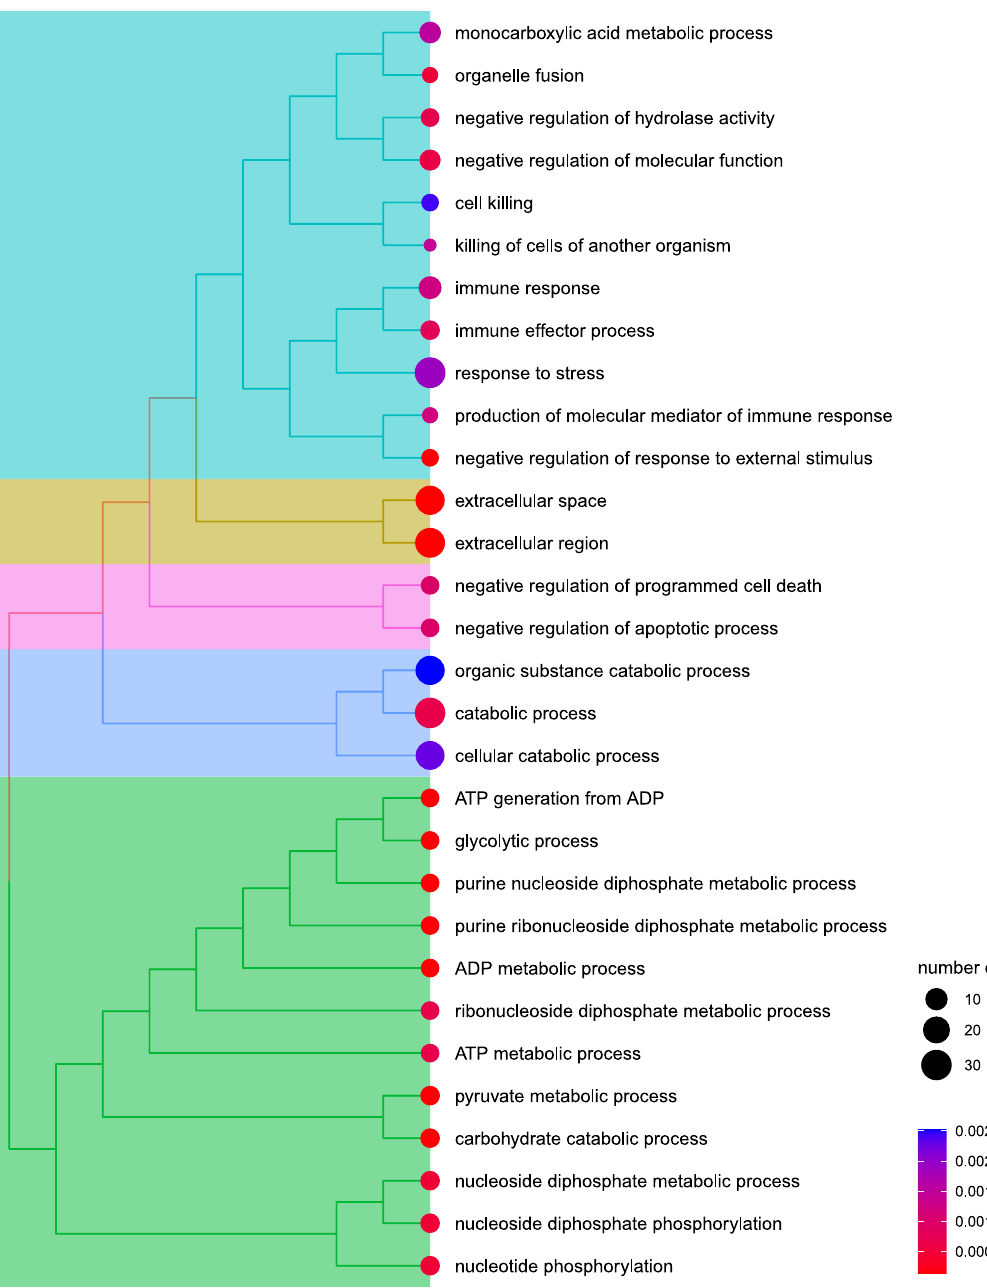
Figure 4. Gene ontology (GO) enrichment analysis of the common nightingale female reproductive tract fluid proteomes. Gene ontology searches revealed that highly expressed proteins are extracellular soluble proteins mostly involved in the maintenance of tissue homeostasis, antimicrobial defence and ATP metabolism. Numbers of enriched genes are reflected by the circle size while Benjamini–Hochberg corrected p-values are scaled from red to blue. Hierarchical clustering of enriched terms relies on the pairwise similarities of the enriched